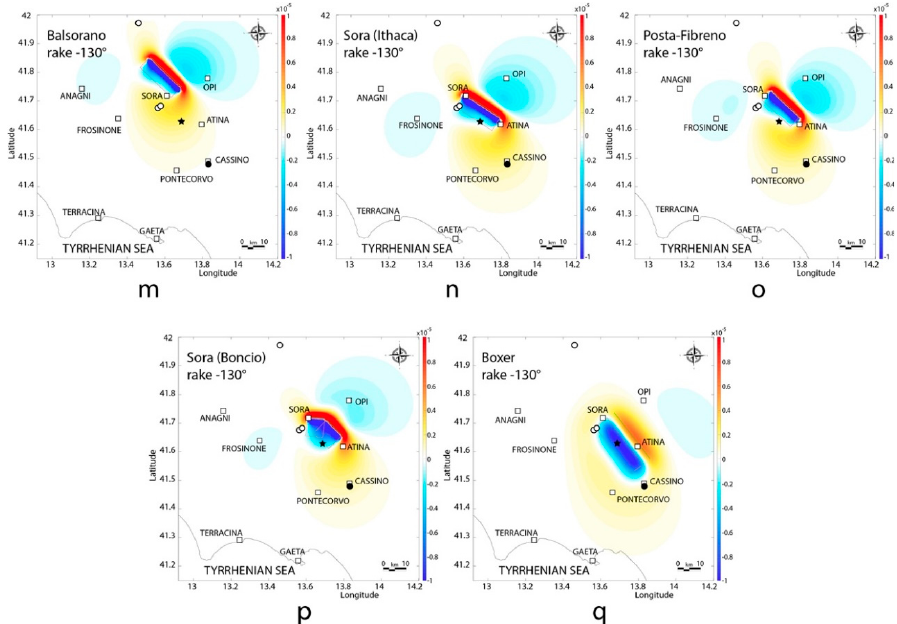
Figure 6. Comparison between the calculated coseismic strain fields along five potential sources and the observed hydrological effects produced by the 1654 earthquake. The calculation of strain was made using Coulomb 3.4 [27,28]. Plots ‘( a - e )’ show the calculations for normal sources (rake -90°), plots ‘( f - l )’ show the calculations for oblique left-lateral sources (rake -50°), and plots ‘( m - q )’ show the calculations for oblique right-lateral sources (rake -130°). In the plots of strain, blue shading indicates areas in compression and red shading indicates areas in dilatation. Units: 10 − 5 . A red rectangle indicates the surface projection of the fault plane; a green line is the intersection of the updip projection of the fault with the surface. Streamflow changes are indicated by circles (black/discharge increase; white/discharge decrease).